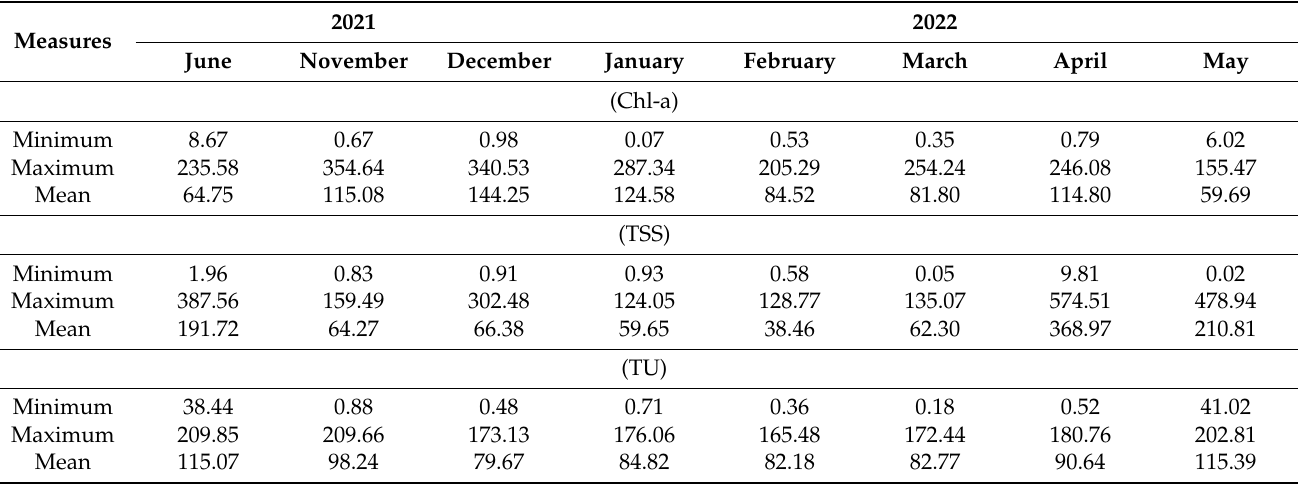
Table 5. Selected regression model for the retrieval of monthly WQPs from Sentinel 2A MSI bands and descriptive statistics of the in situ-measured and predicted water quality